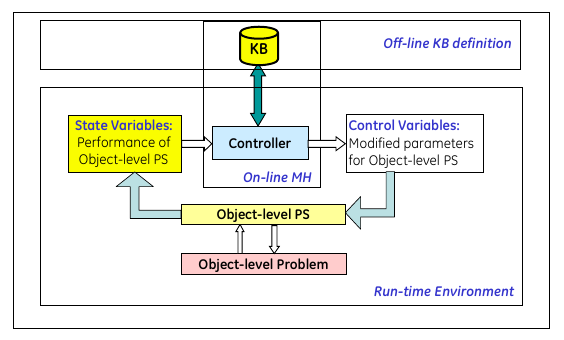
Fig. 3. Schematic of Online Meta-Heuristics (adapted from reference